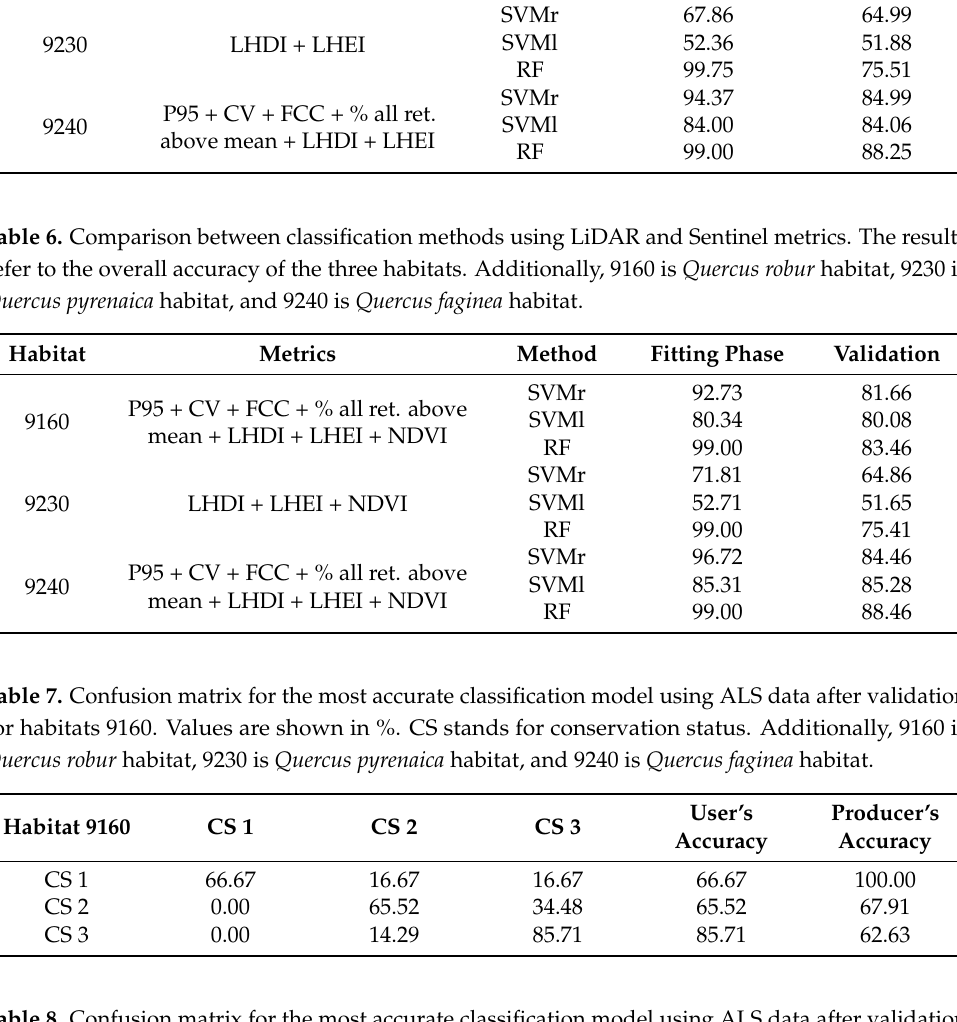
Table 8. Confusion matrix for the most accurate classification model using ALS data after validation for habitats 9230. Values are shown in %. CS stands for conservation status. Additionally, 9160 is Quercus robur habitat, 9230 is Quercus pyrenaica habitat, and 9240 is Quercus faginea